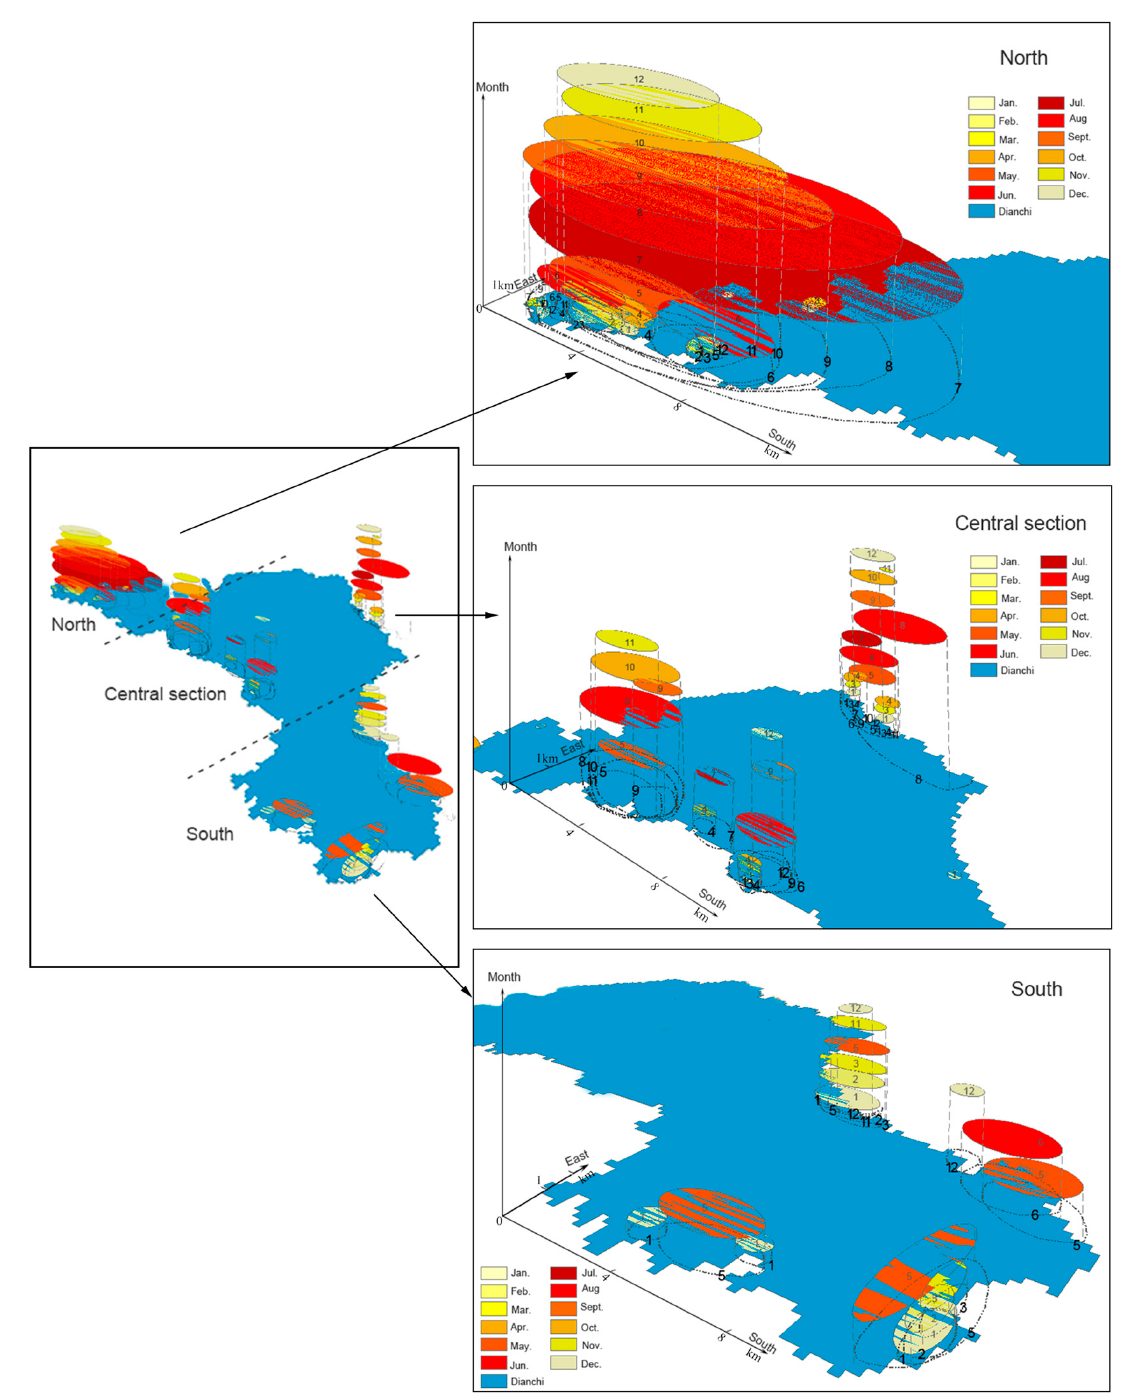
Figure 11. Variation in the spatiotemporal trajectory of monthly high-ABF areas in Lake Dianchi. 1–12 Numbers represent January to December.